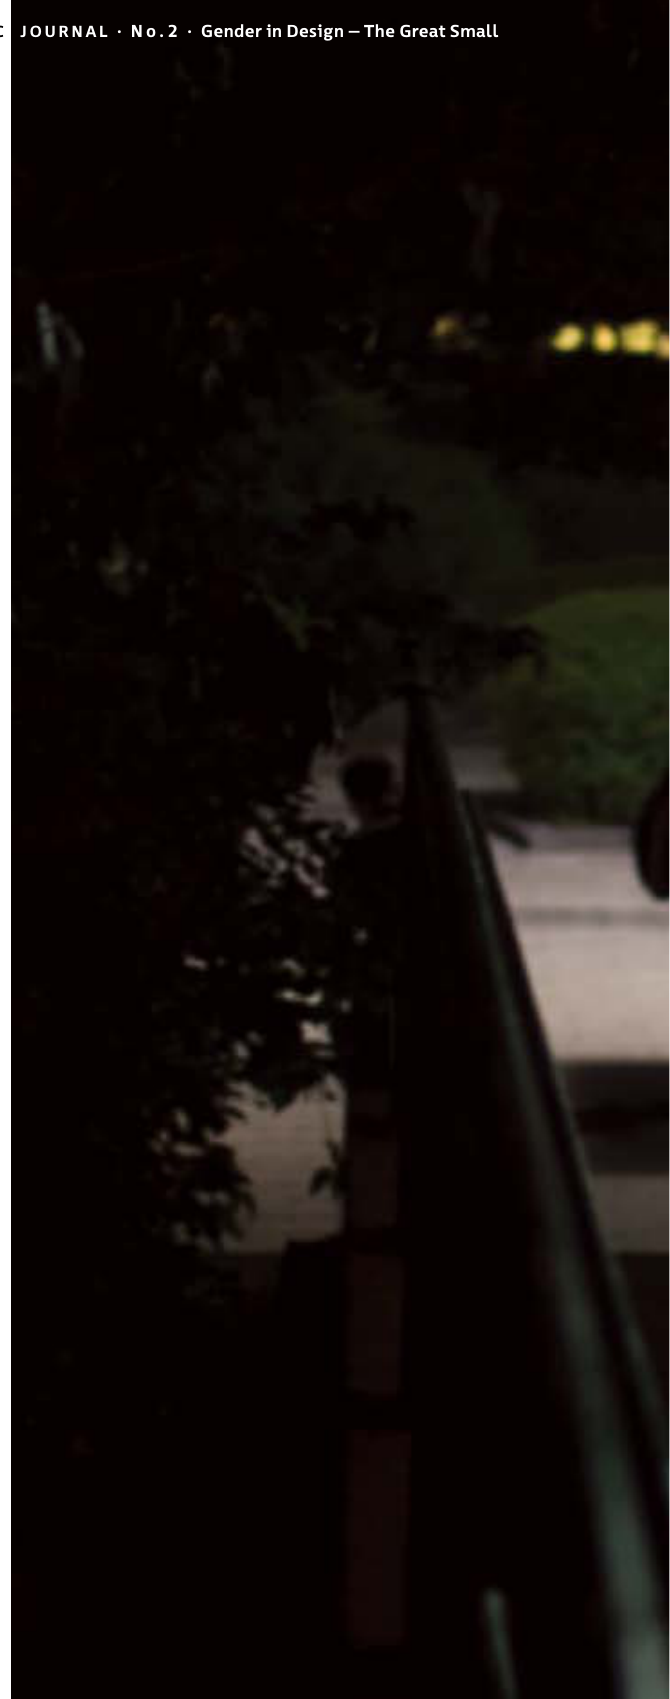
Figure 7 (page 112, top): Tunnels, Kowloon Park. Source: Liao Jiaming 2018. Figure 8 (page 112 bottom): Bamboo, Kowloon Park. Source: Liao Jiaming 2018. Figure 9 (page 113, top): Sitting for religious study, Kowloon Park. Source: Tim Tang 2018. Figure 10 (page 113, bottom): Sitting and waiting, Kowloon Park. Source: Liao Jiaming 2018. Figure 11 (page 114): City lights create shadowy spaces, Kowloon Park. Source: Liao Jiaming 2018. Figure 12 (page 115): Hiding in shadows from the light, Kowloon Park. Source: Liao Jiaming 2018. Figure 13 (right): Walking among the light and the dark, Kowloon Park. Source: Liao Jiaming